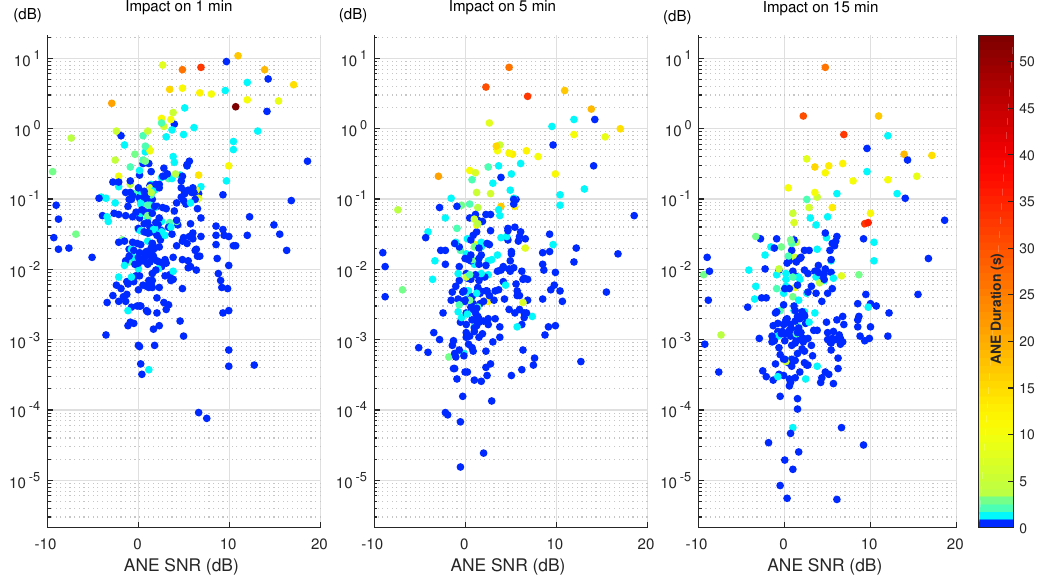
Figure 4. Impact of individual ANEs on the L Aeq value for the 1, 5 and 15 min integration times in the urban